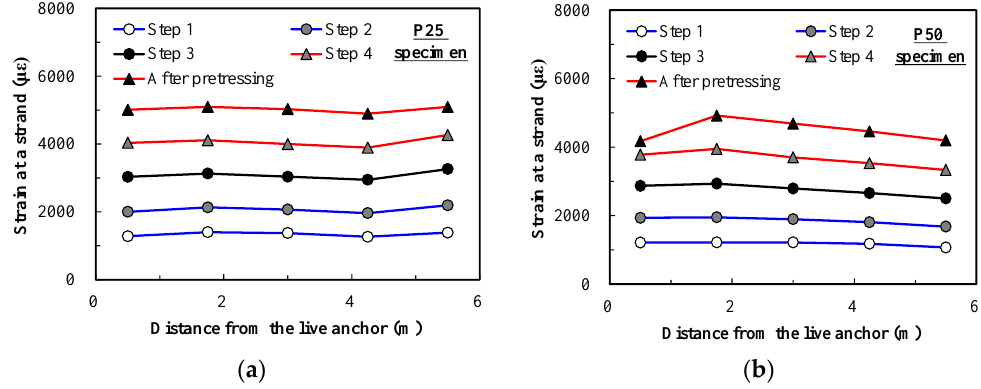
Figure 11. Strain measured by embedded FBG sensors. ( a ) P25 specimen; ( b ) P50 specimen.